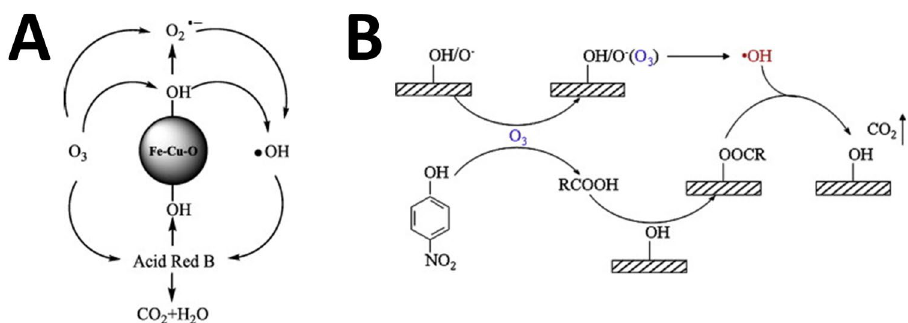
Figure 4. ( A ) Mechanism of catalytic ozonation Acid Red B; ( B ) Mechanism of catalytic ozonation of p-nitrophenol over Mn–Co–Fe. Reproduced with permission from Ref. [64,66].